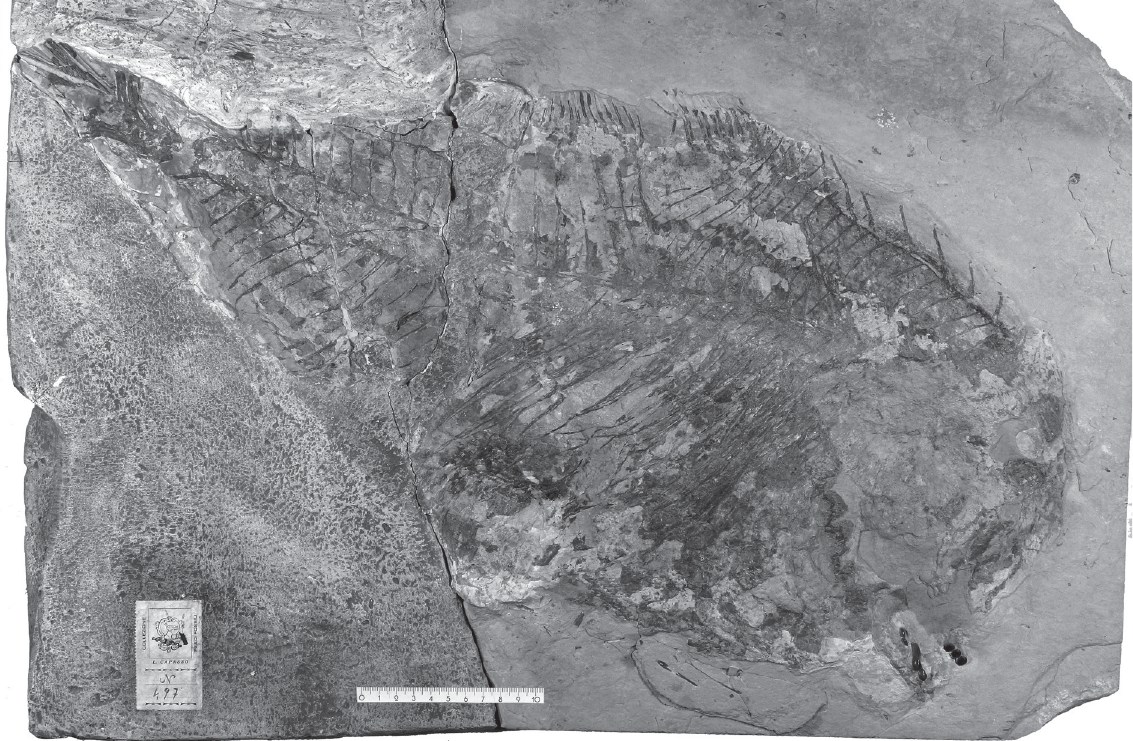
Fig. 12. Sigmapycnodus giganteus gen. et sp. nov., holotype (CLC S-497a), slab a.